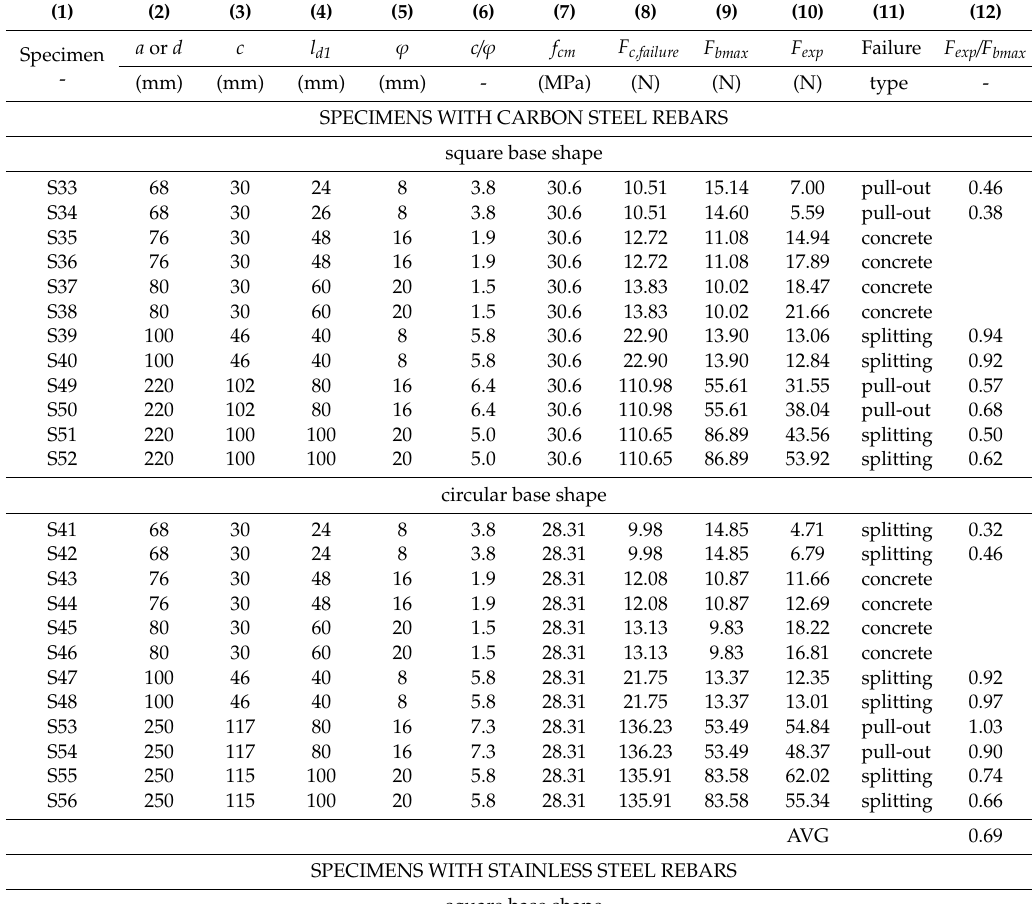
Table 1. Characteristics of the specimens and experimental